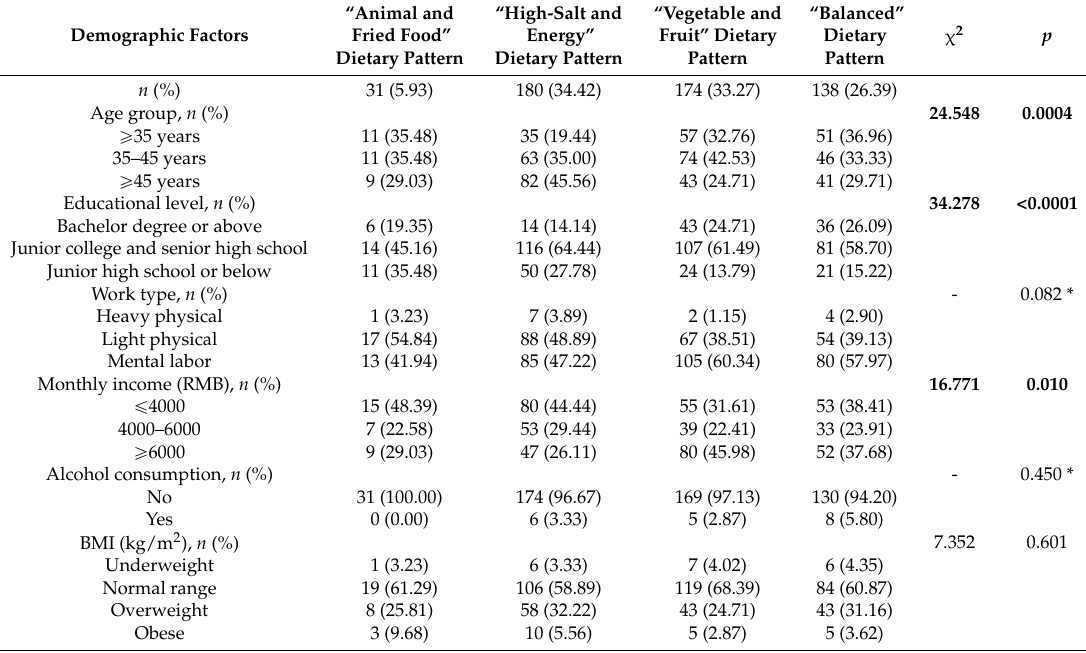
Table 7. Distributions of sample characteristics among women by four dietary patterns. Demographic Factors